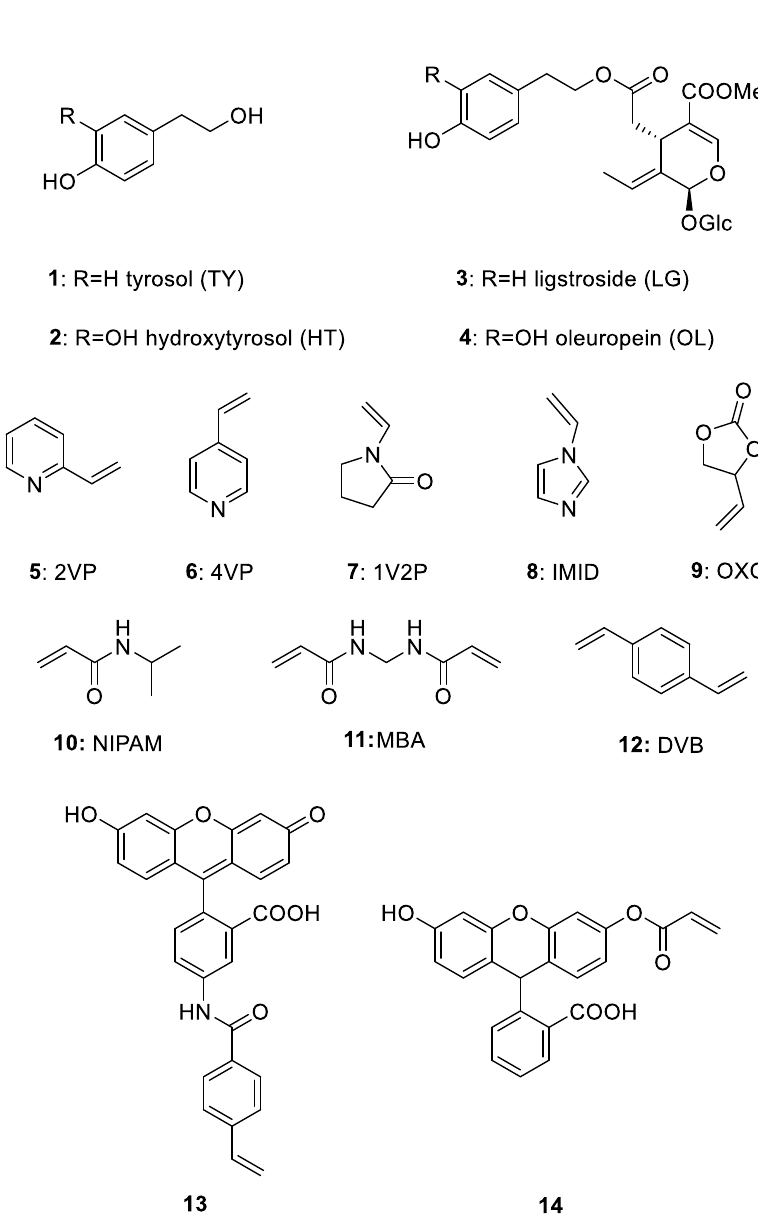
Figure 1. Chemical structures of tyrosol (TY) 1 , hydroxytyrosol (HT) 2 , ligstroside (LG) 3 , oleuropein (OL, Glc: glucose) 4 and of monomers 5 – 9 , co-monomers 10, 13, 14 and cross-linkers 11, 12 .